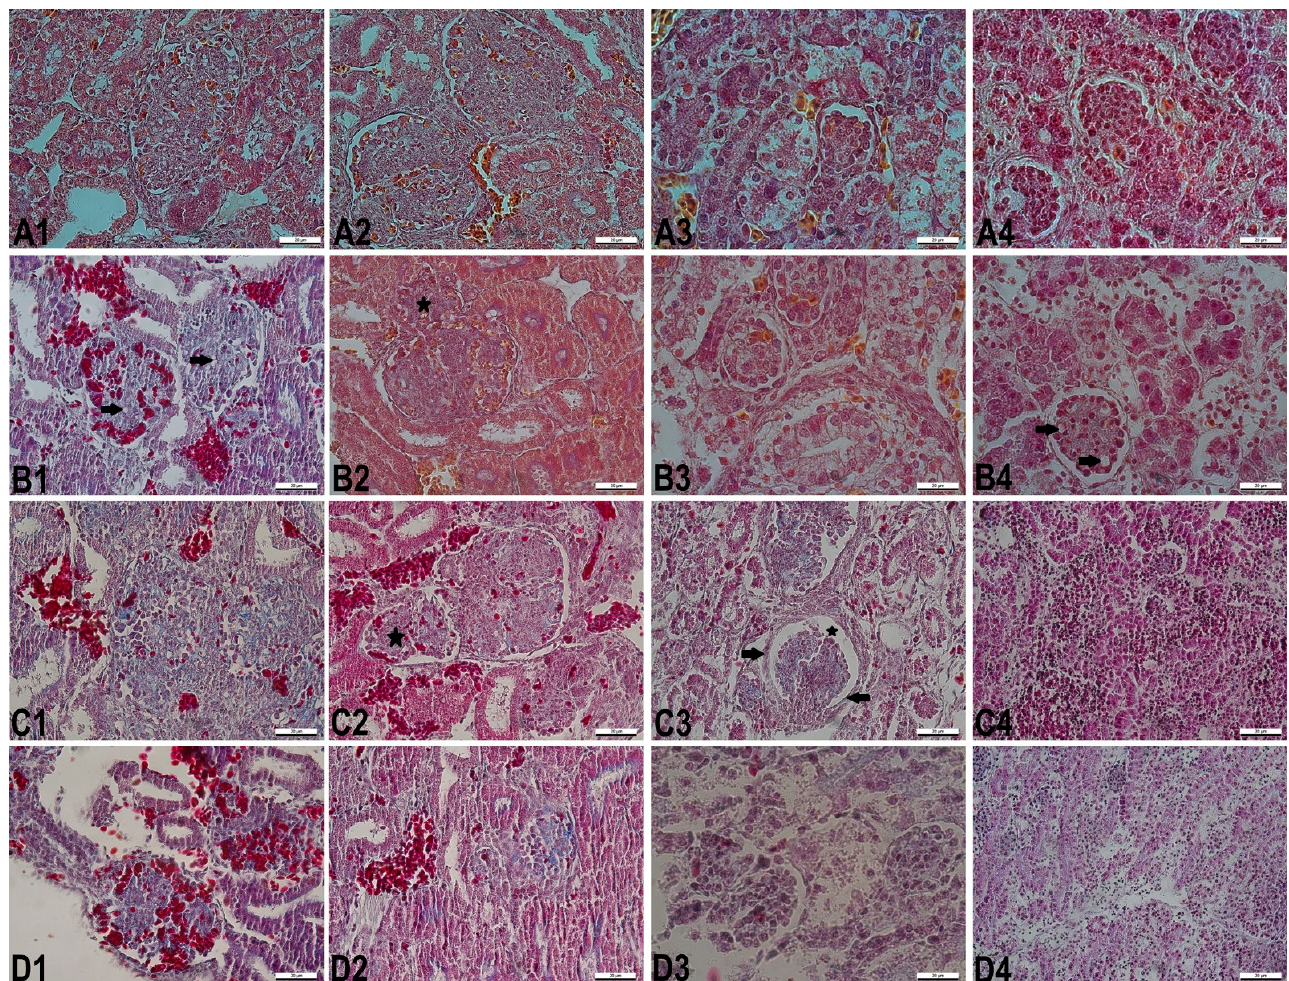
Figure 2. The kidney sections in different embryonic periods. ( A1 – A4 ): Normal histological structure in the control group. ( B1 – B4 ): The kidney sections from chick embryos treated with SY 200 . ( B1 ): Spills in the renal tubules epithelium, vacuoles in glomeruli (arrowheads), congestion of glomerular tufts, intertubular hemorrhage foci, and periglomerular leukocyte infiltration (day 10). ( B2 ): Congestion of glomerulus and intertubular blood vessels, and diminished glomerulus (star) (day 13). ( B3 ): Severe spills in the renal tubules epithelium, swelling in some tubule epithelial cells, and slightly hyperemia in the intertubuler region (day 16). ( B4 ): Marked vacuoles in glomeruli tufts (arrows), degenerated and destructed renal tubules, marked nuclear disorders, necrosis of most tubular epithelium (day 21). ( C1 – C4 ): The kidney sections from chick embryos treated with SY 1000 . ( C1 ): Highly degenerated and distorted glomeruli/renal tubules, intertubular hemorrhage foci, and inflammatory cells infiltration in renal cortex (day 10). ( C2 ): Slightly congestion of glomeruli, severe intertubular hemorrhage, atrophied glomerulus (star), and dilated tubules (day 13). ( C3 ): Thickened parietal layer of Bowman’s capsule (arrows), dilatation of Bowman’s space (star), diminished glomerulus, degenerated tubules, and marked fibrosis in the glomerular tufts (day 16). ( C4 ): Highly massive infiltration of inflammatory cells in renal cortex region (day 21). ( D1 – D4 ): The kidney sections from chick embryos treated with SY 2000 . ( D1 ): Highly massive hemorrhage in glomerular tufts and intertubular region, and partially degenerated renal tubules (day 10). ( D2 ): Atrophied and destructed glomerulus, degenerated tubules, and massive hemorrhage (day 13). ( D3 ): Degeneration and destruction of most tubules, deterioration of renal corpuscular integrity, and tubular necrotic foci (day 16). ( D4 ): Highly massive infiltration of inflammatory cells in renal cortex region, degeneration and destruction of most renal tubules (day 21). Crossmon’s trichrome staining. Bar = 20 µ